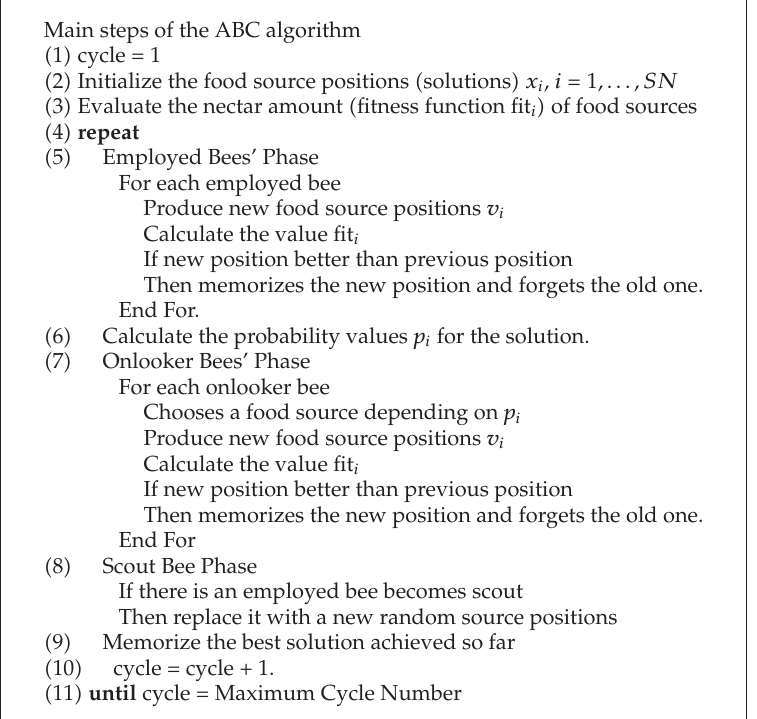
Algorithm 1: Pseudocode for ABC algorithm.